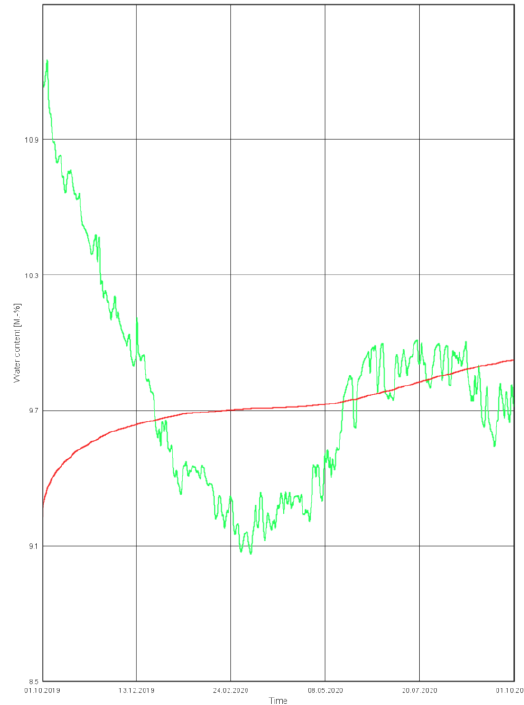
Figure 30. Changes in water content in wooden beams (red) and deck boards (green) for the alternative featuring internal thermal insulation.